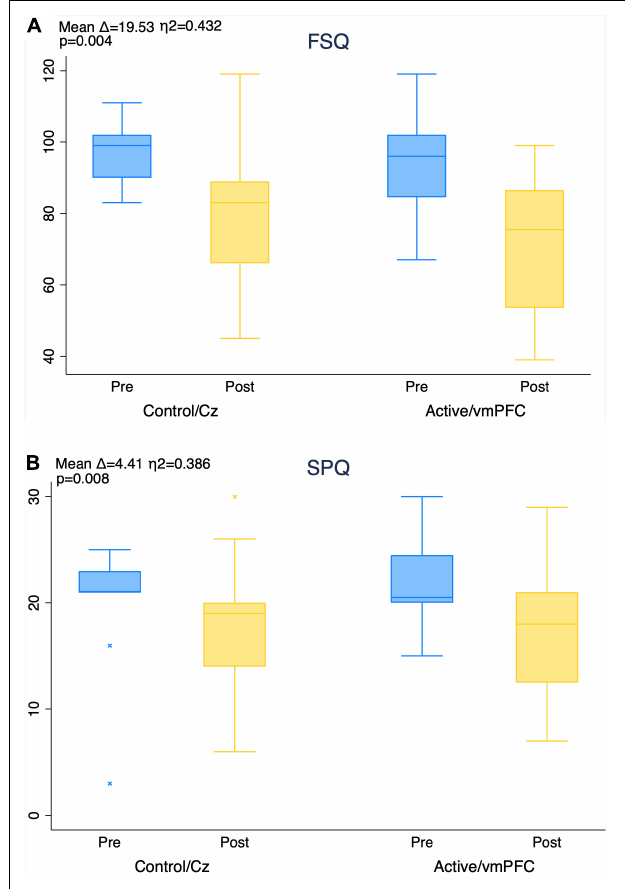
FIGURE 5 | Improvement in fear of spiders questionnaire (FSQ, A ) and spider phobia questionnaire (SPQ, B ) scores from pre- to post-treatment by group. Mean score improvement (mean delta), MANOVA level of significance, and effect size (eta-squared) of aggregate subject pool provided for timepoint comparison in each figure. No between-group effects found using